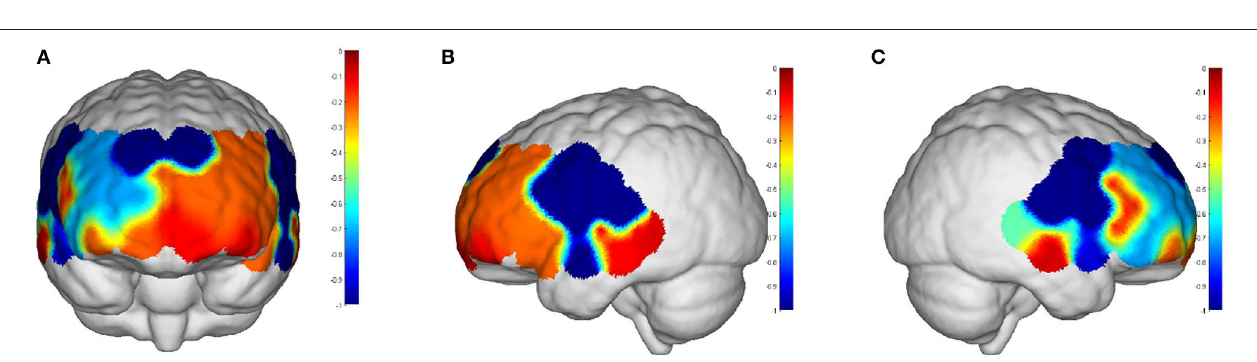
FIGURE 7 | The p- values of task period in older adults compared to the young: (A) front view; (B) left view; (C) right view. The red areas are shown in prefrontal and DPLFC, which were p > 0.05.